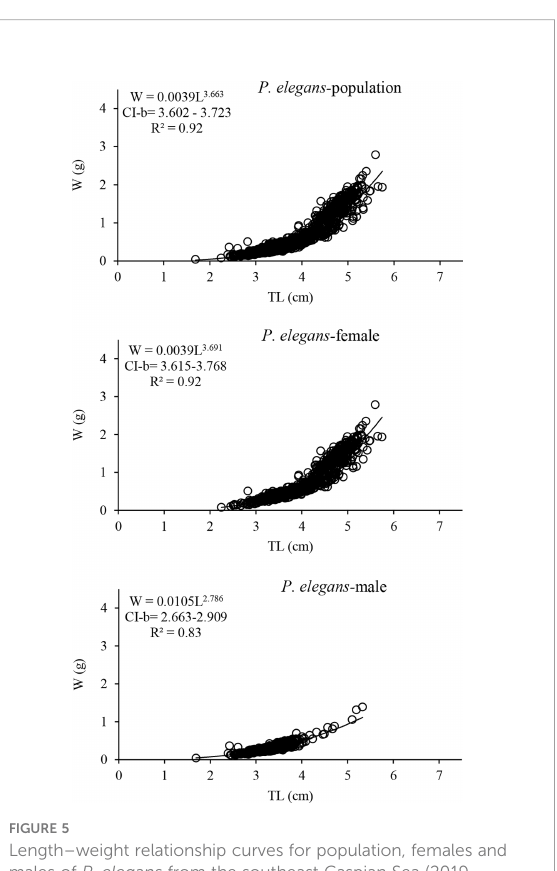
FIGURE 4 Length-weight relationship curves for population, females and males of P. adspersus from the southeast Caspian Sea (2019 – 2020).